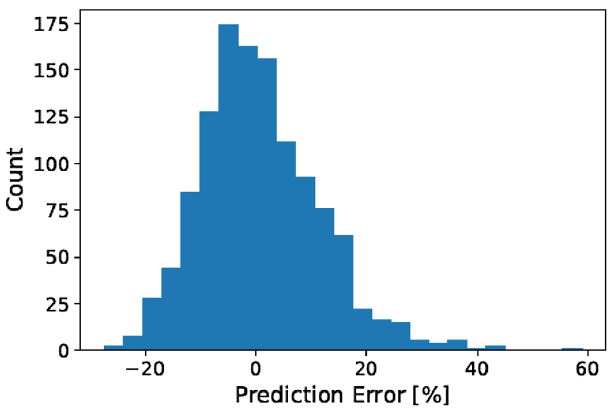
FIG. 20. Histogram of prediction errors for